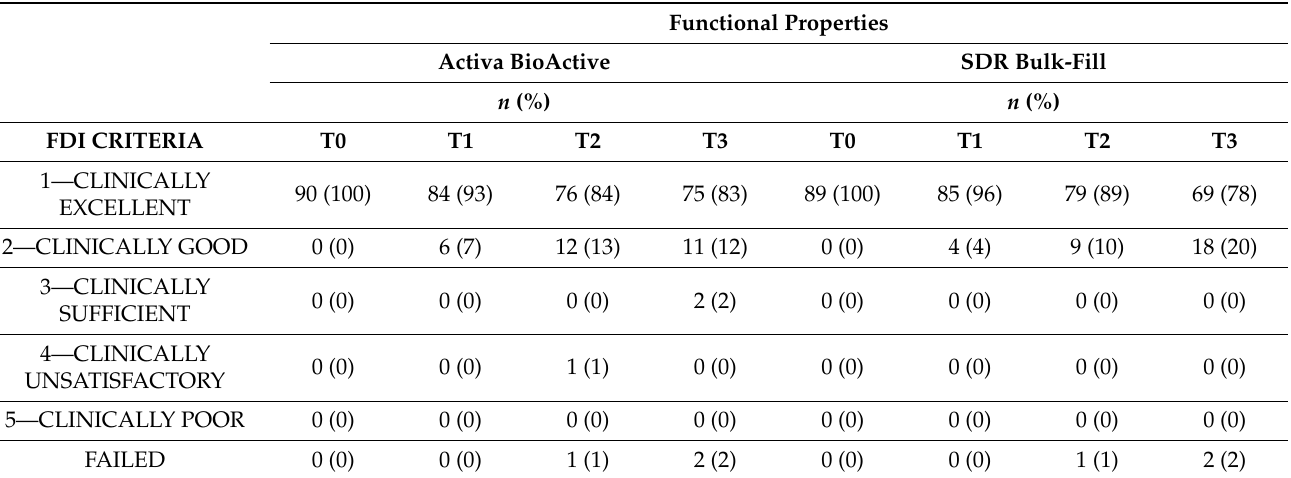
Table 7. Functional properties evaluation based on FDI